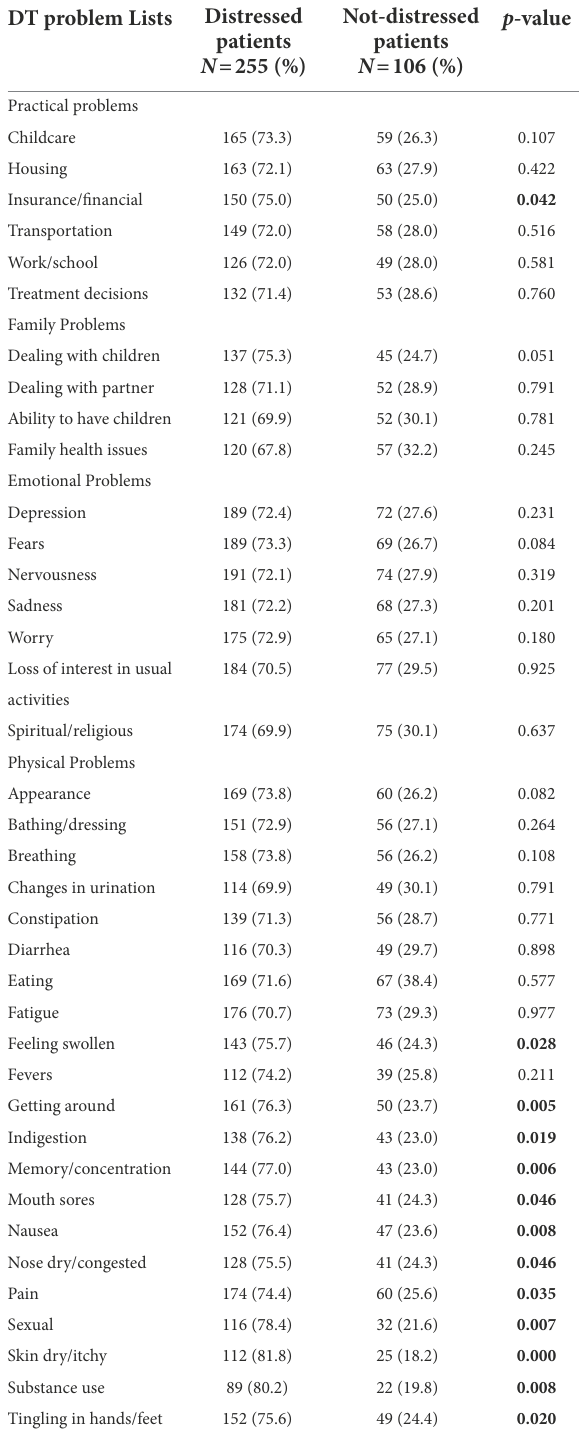
TABLE 2 List of problems influencing distress